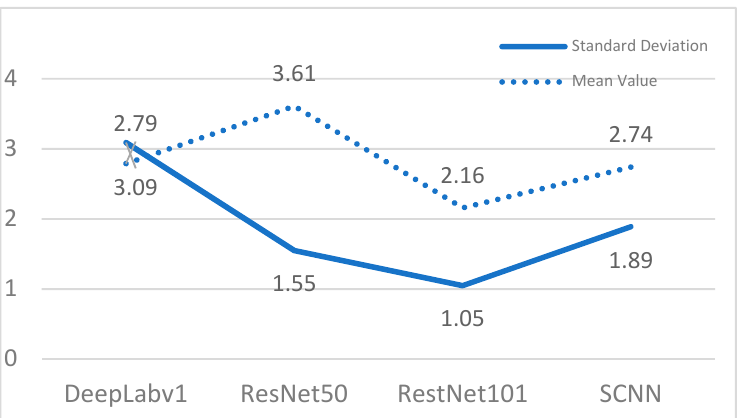
Figure 6. Mean and standard deviation of F 1 Measure improvement in each